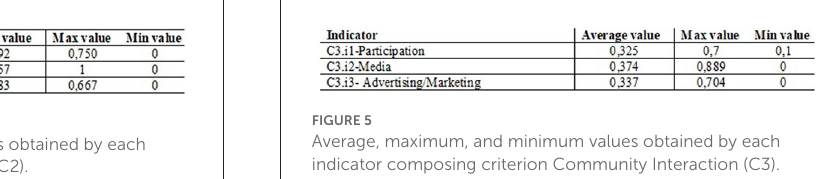
Participation (C3.i1) indicator (Figure 5) has an AV of